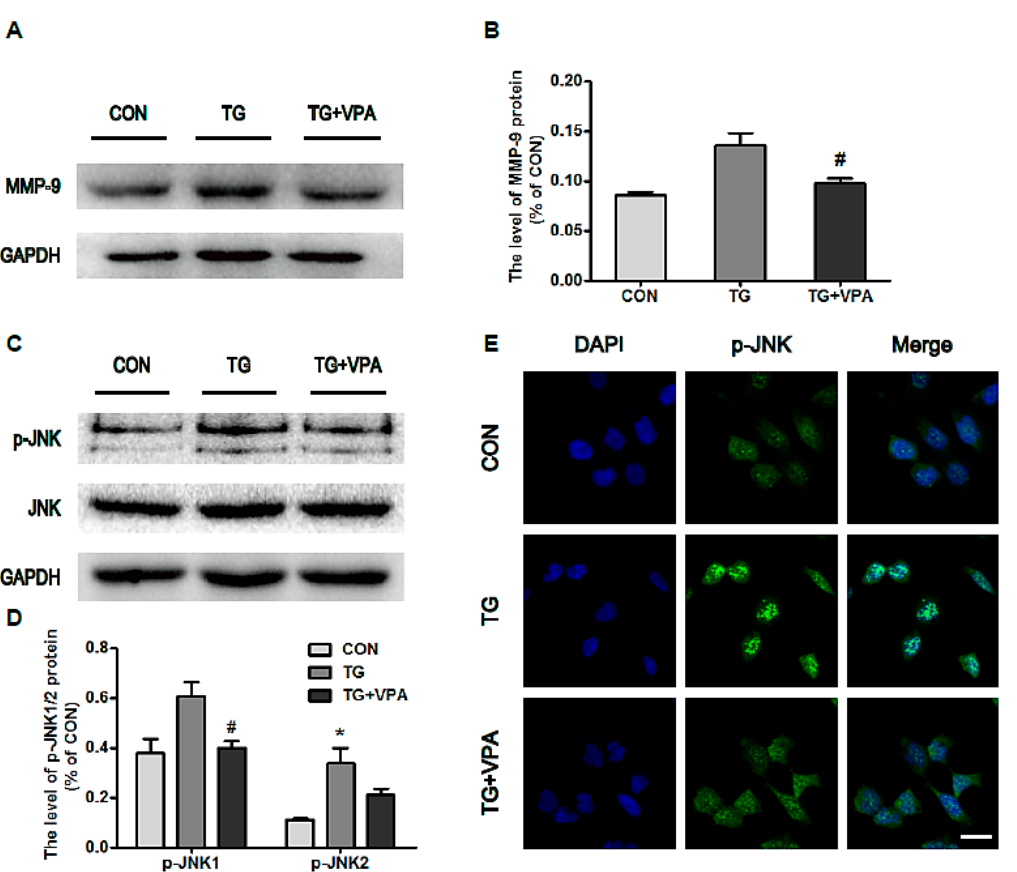
Figure 7. VPA inhibits the expression of MMP-9 and the phosphorylation of JNK. ( A ) Protein level of MMP-9 after VPA treatment; ( B ) Densitometric analyses of MMP-9, # p < 0.05 versus the TG group; ( C ) Protein level of p-JNK1/2 in the control, TG, and TG and VPA groups. n = 3; ( D ) The optical density analysis of p-JNK1/2, # p < 0.05 versus the TG group, * p < 0.05 versus the control group; ( E ) Immunofluorescence of p-JNK (green) and the nuclear (blue). Magnification was 40 × . Data are the mean values ± SEM, n = 3.